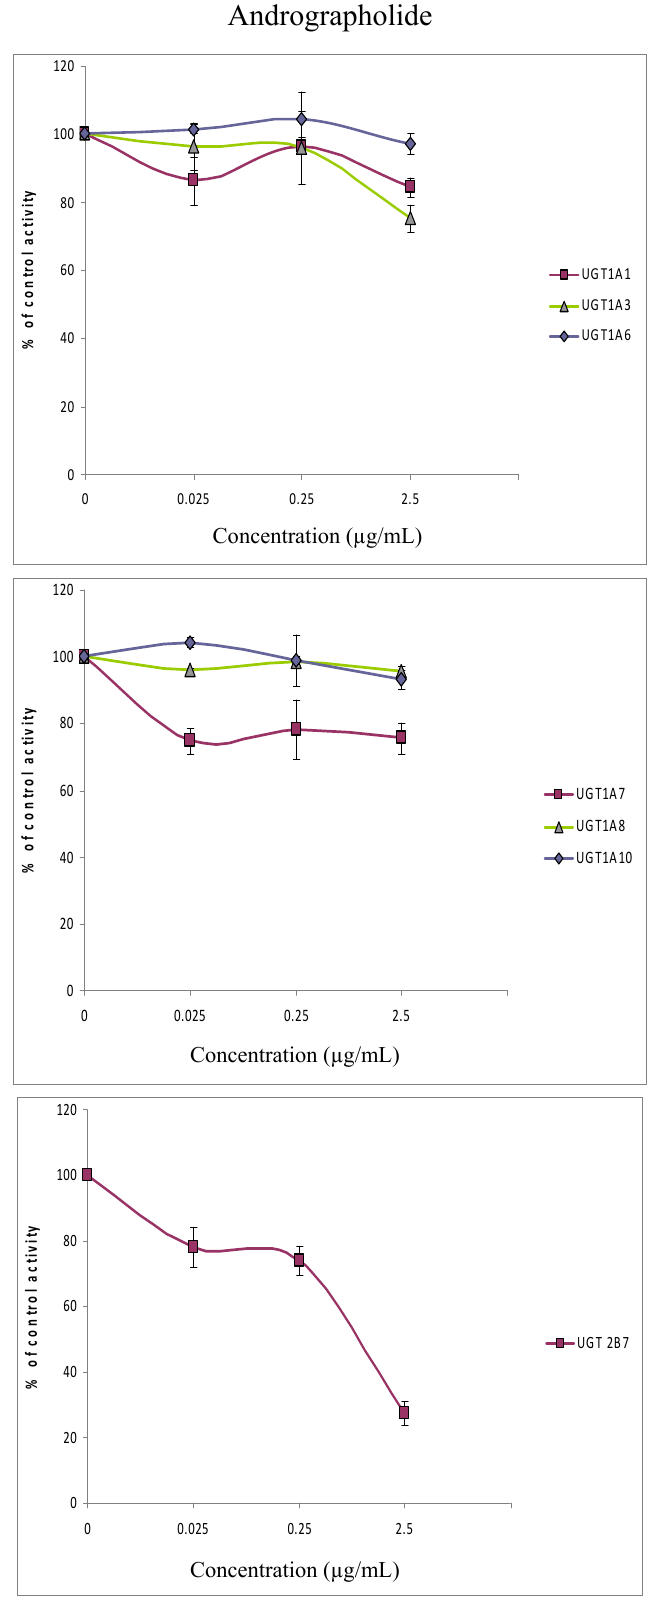
Figure 3. Effects of andrographolide (0.025–2.5 µg/mL) on the glucuronidation of 4-methylumbelliferone in recombinant human isoforms (UGT1A1, UGT1A3, UGT1A6, UGT1A7, UGT1A8, UGT1A10, UGT2B7) presented as percentage of control. Data are expressed as means and range of two